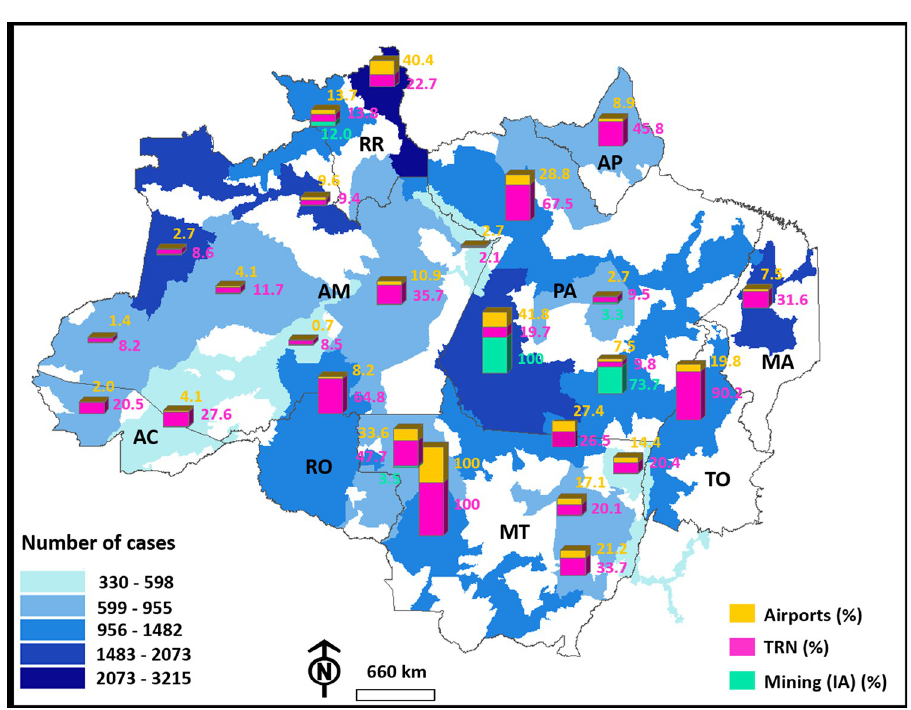
Fig 4. The number of COVID-19 cases among indigenous people in the DSEIs of Brazil’s Legal Amazon as a function of the relative percentage of air transport network, total road network (TRN), and natural vegetation area converted into mining areas within the IAs of the DSEIs. Base layer obtained from: https://www.gov.br/funai/ pt-br/atuacao/terras-indigenas/geoprocessamento-e-mapas.